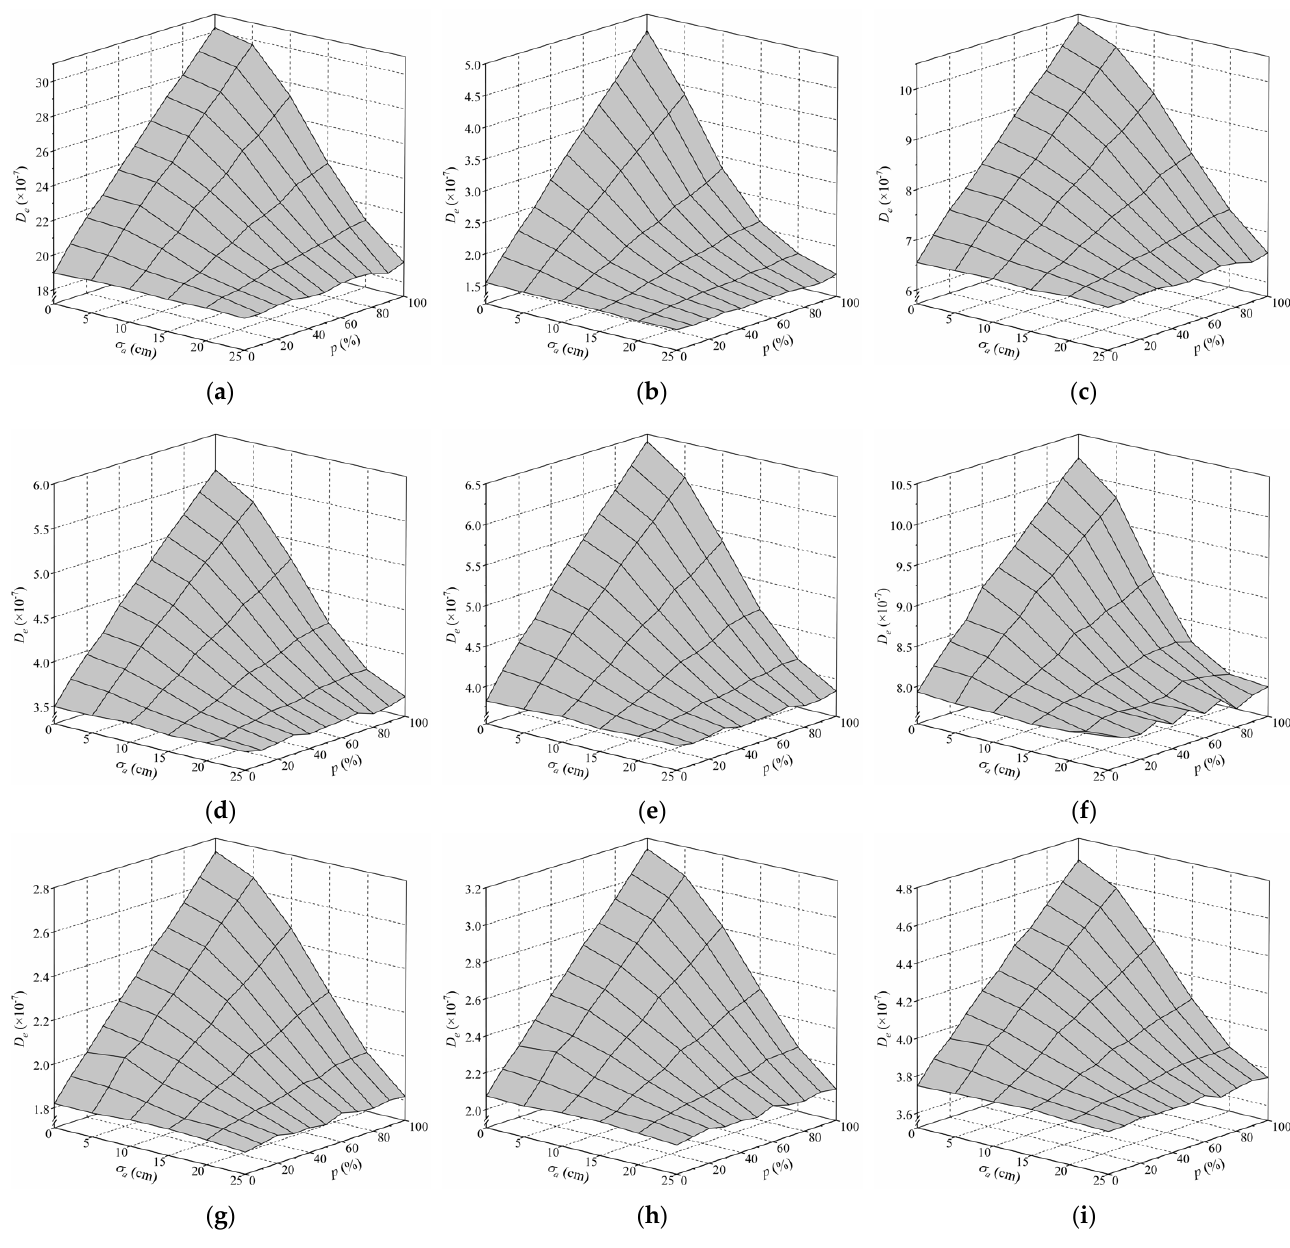
Figure 10. Equivalent fatigue damage of fatigue details induced by a single standard fatigue truck: